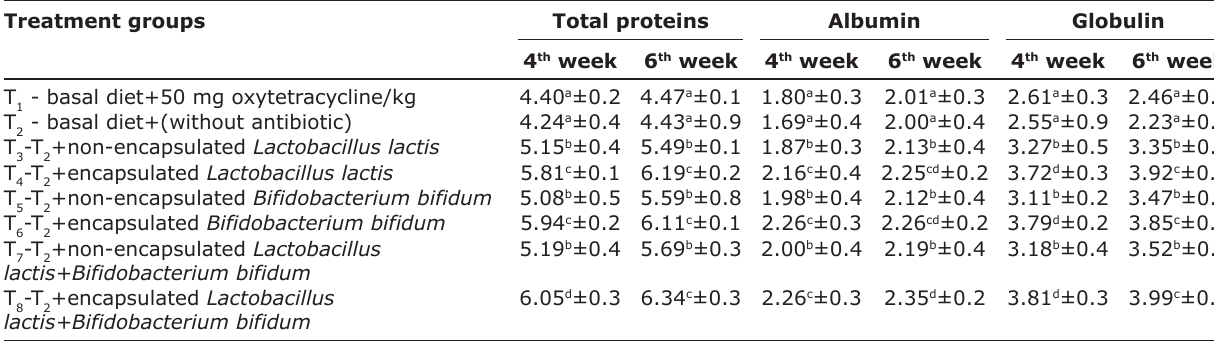
Table-1: Mean (±S.E.) plasma protein profile (g/dL) of broiler chickens supplemented with non-encapsulated and encapsulated probiotic bacteria.